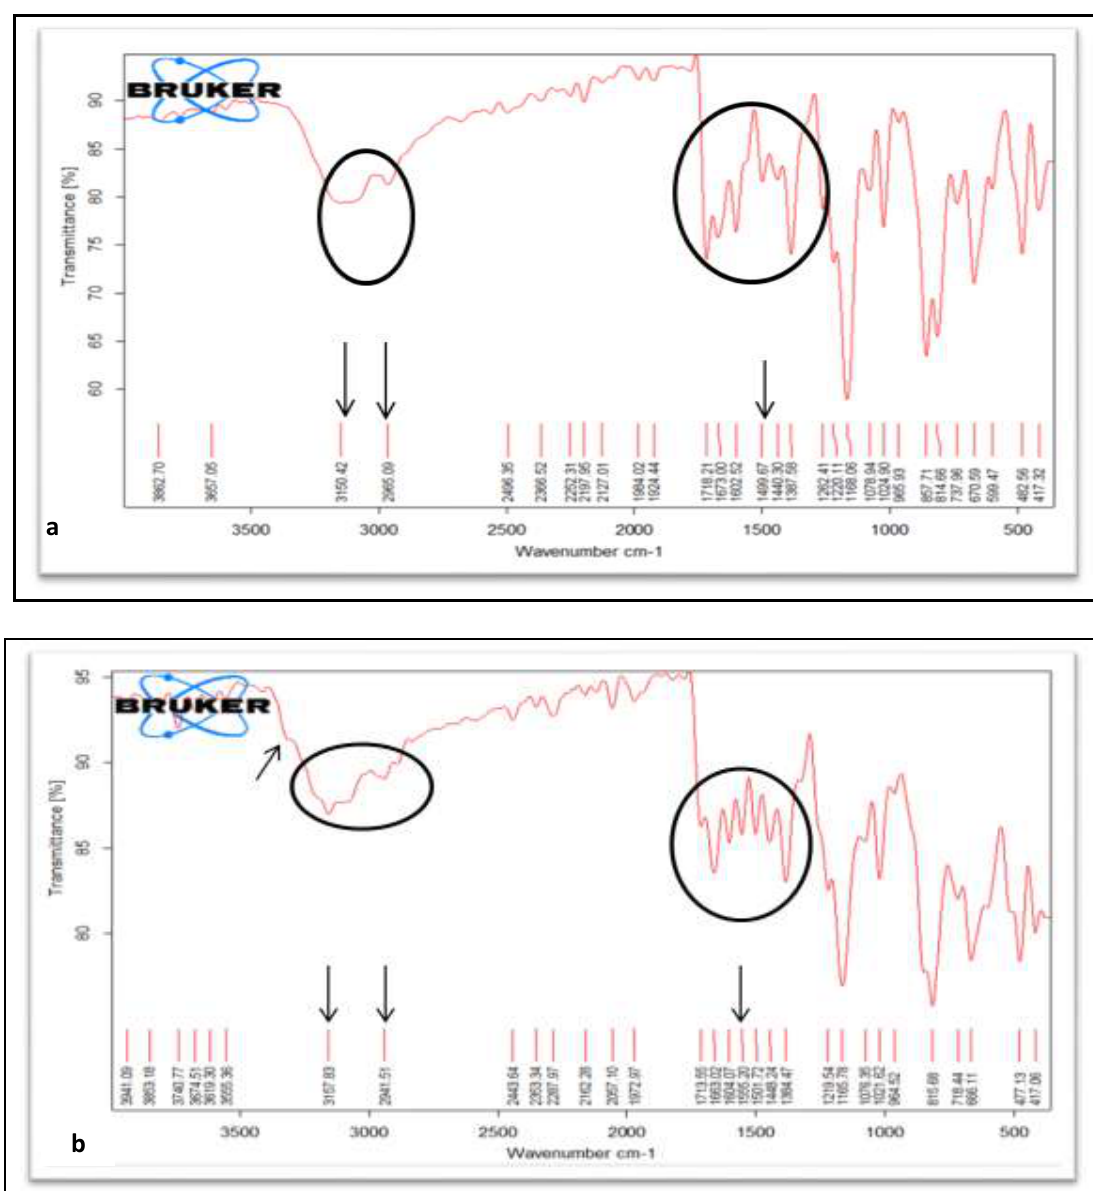
Figure 4. FTIR spectrum of 1:1 paracetamol/ naproxen mixtures. a) C1 physical mixture. b) N1 prepared co-crystal